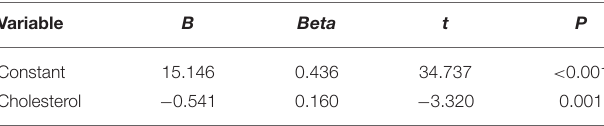
TABLE 6 | Regression analysis of diet consumption on the effects of diet on